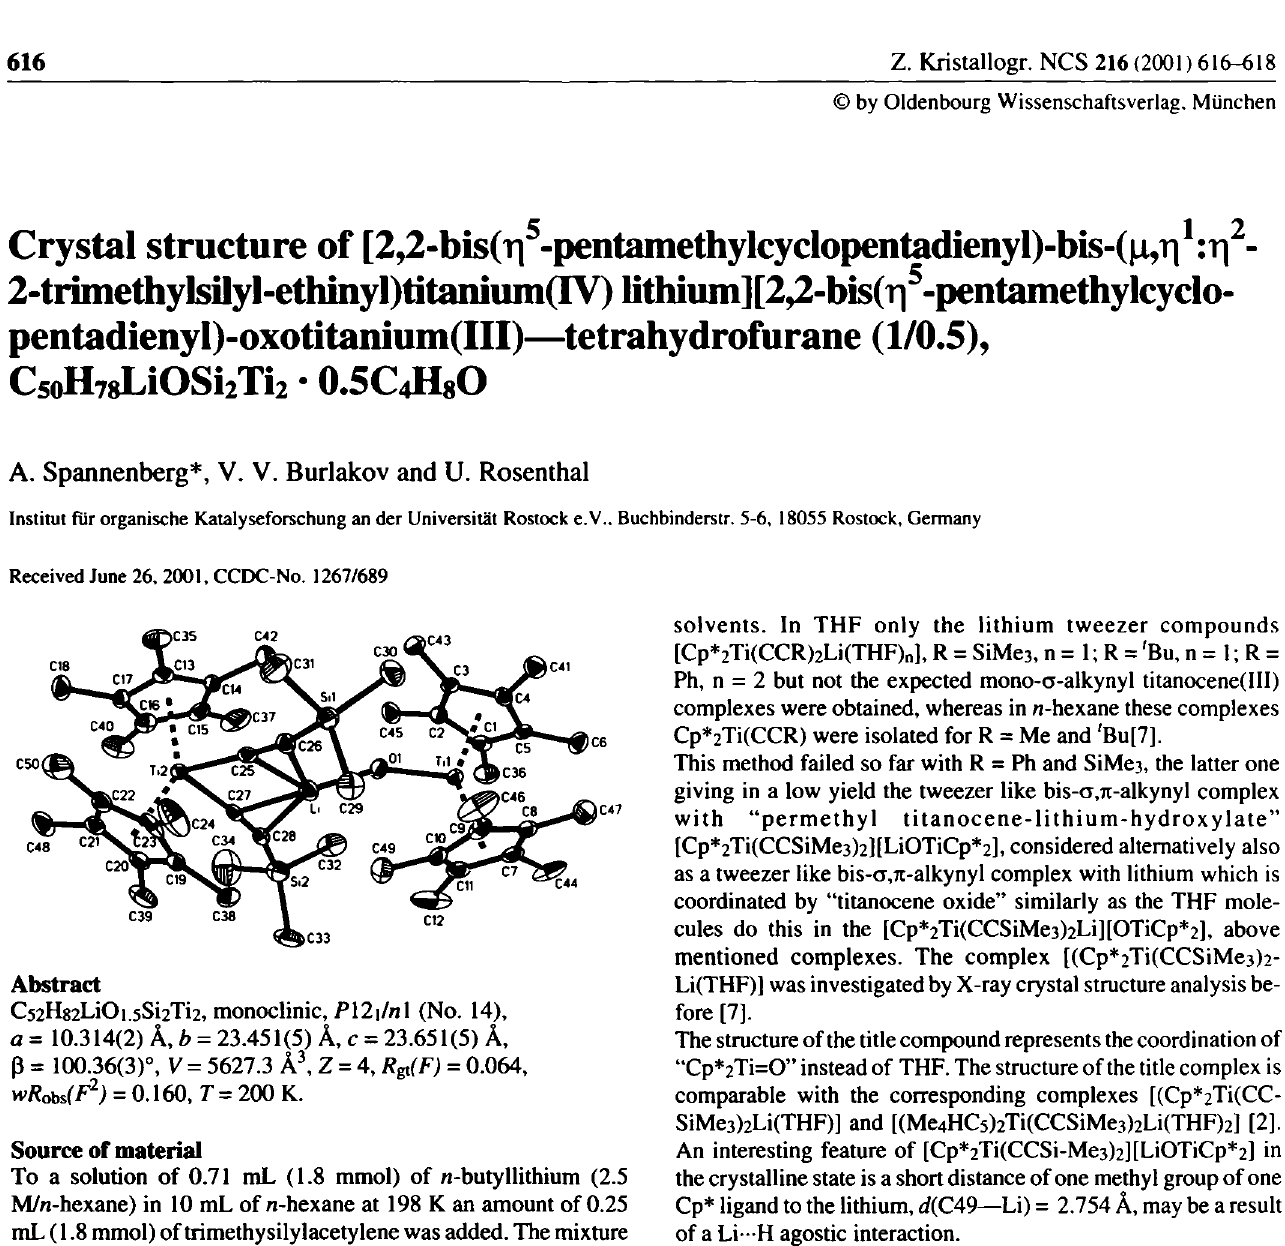
Table 1. Data collection and handling.